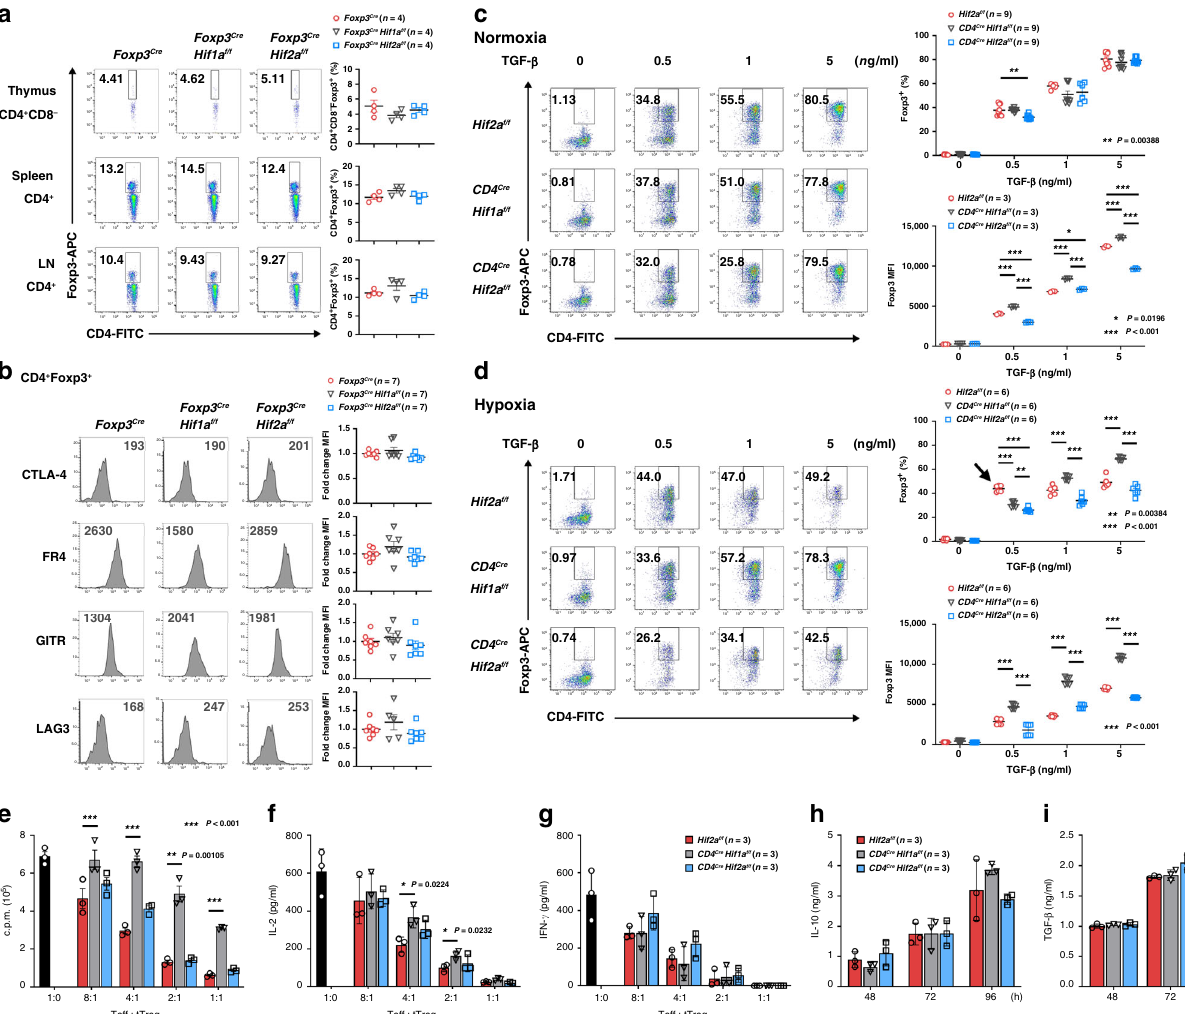
Fig. 1 HIF-2 α KO does not affect Treg cell development or in vitro tTreg suppressive activity. a CD4 + Foxp3 + T cell populations in thymus, spleen, and peripheral lymph nodes (LN) of Foxp3 Cre (WT), Foxp3 Cre Hif1a f/f , and Foxp3 Cre Hif2a f/f mice. Left, representative plots. Right, data expressed as mean ± SEM, n = 4 biologically independent mice. Red circle, Foxp3 Cre ; black inversed triangle, Foxp3 Cre Hif1a f/f ; blue square, Foxp3 Cre Hif2a f/f . b Expression of CTLA-4, FR4, GITR, and LAG-3 in Foxp3 Cre , Foxp3 Cre Hif1a f/f , and Foxp3 Cre Hif2a f/f tTreg cells. Left, representative traces of MFI. Right, ratios of the MFIs of HIF-1 α -KO or HIF-2 α -KO tTreg to WT tTreg cells are expressed as the mean ± SEM, n = 7 mice. c , d Naïve T cells from Hif2a f/f (WT), Cd4 Cre Hif1a f/f , and Cd4 Cre Hif2a f/f mice were activated with anti-CD3/CD28 (2/1 μ g ml − 1 ) with different doses of TGF- β and IL-2 (20 ng ml − 1 ) under normoxia c or hypoxia (1% O 2 ) d for 3 days. Left, representative plots of Foxp3 staining. Right, percentages of Foxp3 + cells and MFIs of Foxp3 are presented as the mean ± SEM, n = 9 (Foxp3 + , c ), n = 3 (Foxp3 MFI, c ), n = 6 d . Symbols are the same as in a except red circle represents Hif2a f/f . * P < 0.05, ** P < 0.01, *** P < 0.001, as determined by two-way ANOVA. Arrow in d indicates a speci fi c increase in Foxp3 + cells among WT iTreg cells. e – g WT CD4 + CD25 − T cells (1 × 10 5 ) were stimulated alone with anti-CD3 (1 μ g ml − 1 ) and T cell-depleted splenic cells or together with Hif2a f/f (WT), Cd4 Cre Hif1a f/f or Cd4 Cre Hif2a f/f tTreg cells at the indicated ratios. CD4 + CD25 − T cell proliferation was measured by thymidine incorporation e , and the production of IL-2 f and IFN- γ g was determined 40 h later. Values are mean ± SD, n = 3 ( e – g ). * P < 0.05, ** P < 0.01, by two-tailed unpaired t- test ( e , f ). h , i Hif2a f/f , Cd4 Cre Hif1a f/f and Cd4 Cre Hif2a f/f tTreg cells were stimulated with anti-CD3/CD28 (4/2 μ g ml − 1 ) and IL-2 for 48 – 96 h. IL-10 ( h ) and TGF- β ( i ) production were determined. n = 4 ( h ), n = 4 ( Hif2a f/f , Cd4 Cre Hif2a f/f ), 2 ( Cd4 Cre Hif1a f/f ) i . Source data are provided as a Source data fi